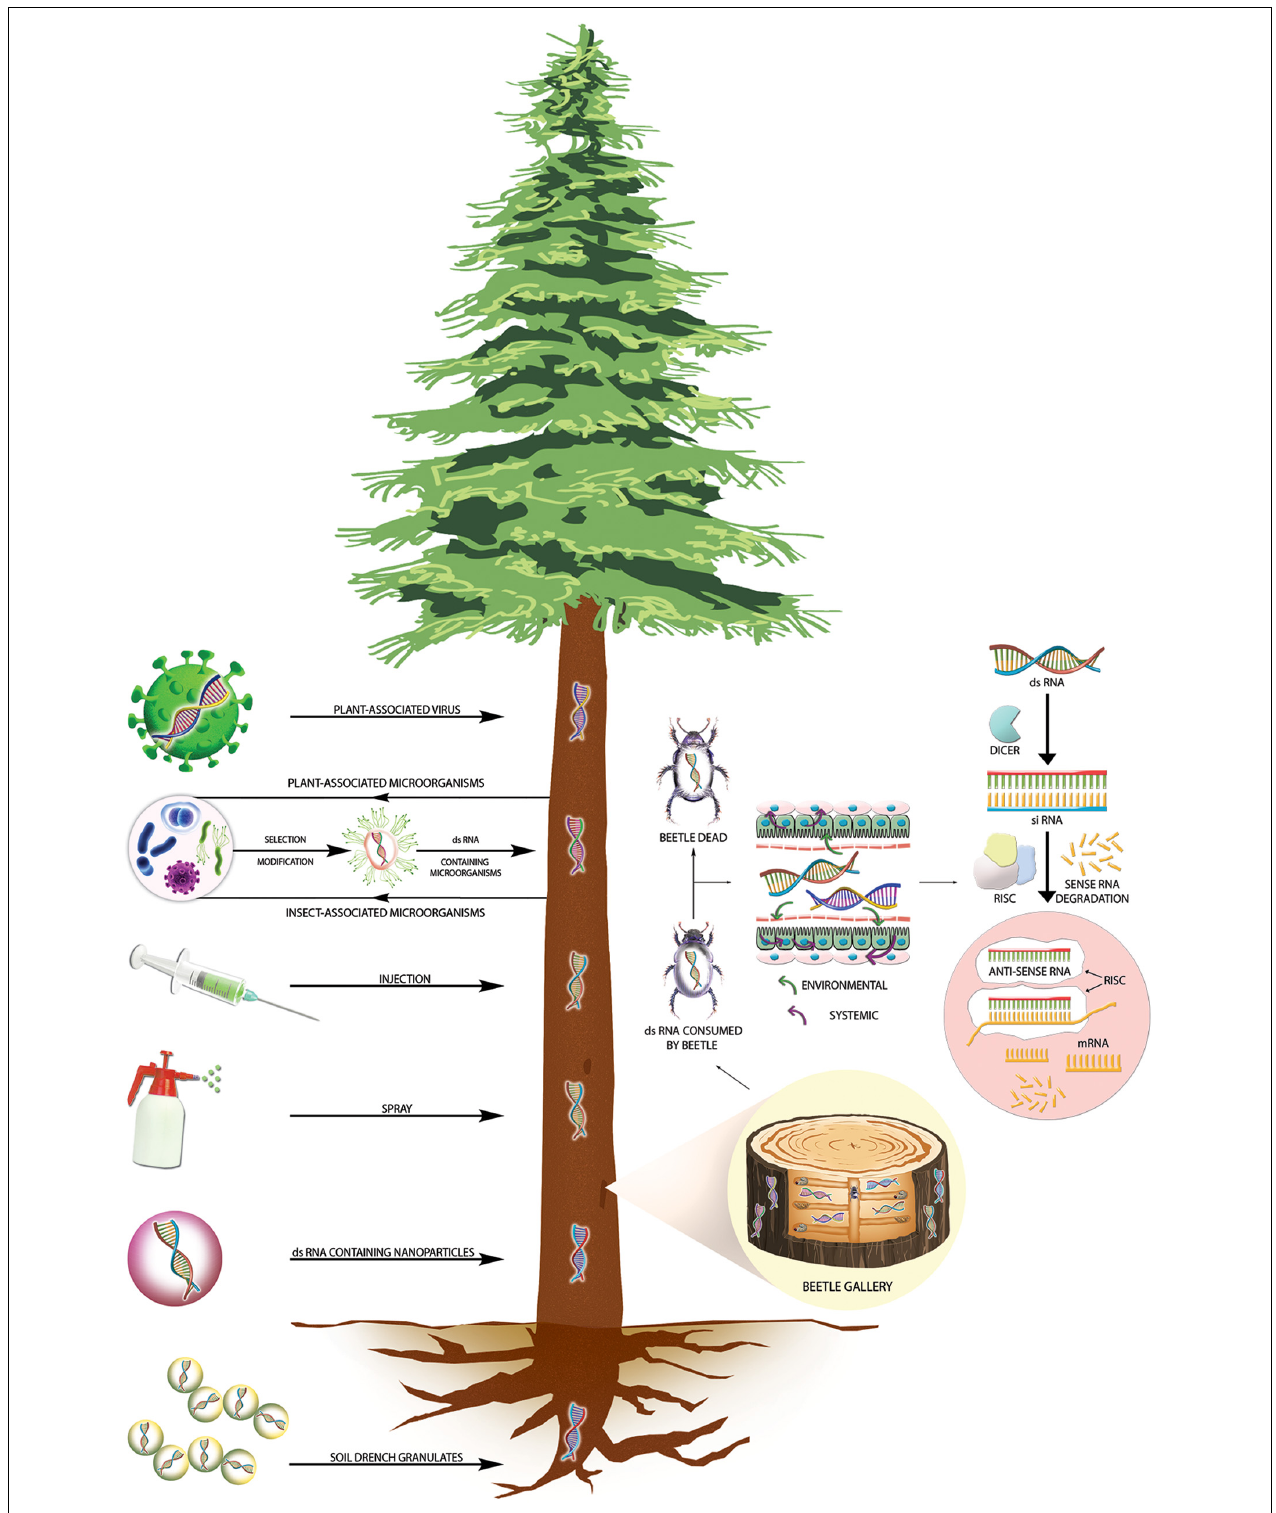
FIGURE 2 | RNAi-mediated plant protection from insect pests at the tree level. The left panel shows different transformative and non-transformative dsRNA delivery strategies to control wood-boring insect pests at the tree level. A section magnified in the right panel shows dsRNA in both vessel systems (xylem and phloem), allowing dsRNA to move up and down and reach the insect galleries. Upon ingestion of dsRNA by wood-boring coleopterans, the dsRNA will reach the gut epithelial cells, where the cellular siRNA mechanism of gene silencing will be initiated, which will lead to target insect death.